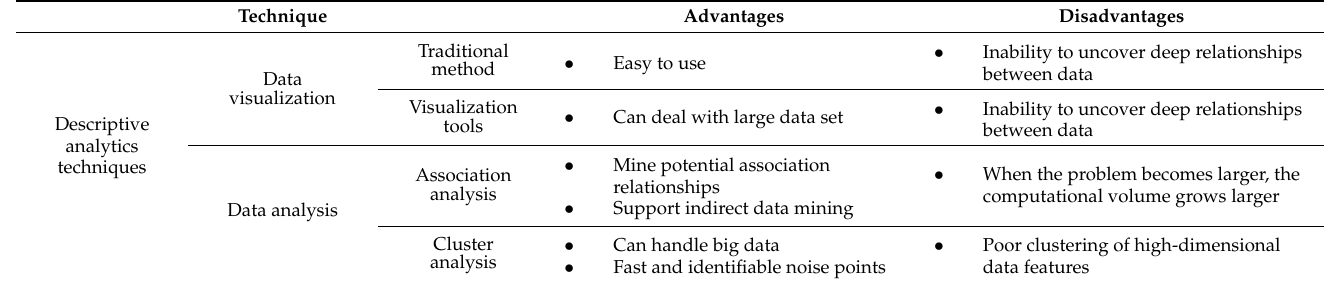
Table 2. Advantages and disadvantages of